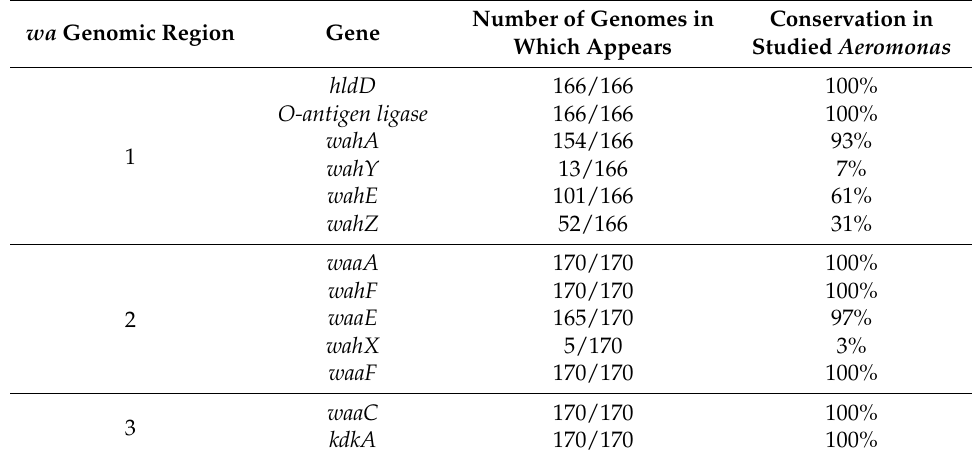
Table 1. Common genes of the wa Regions 1, 2, and 3, and their conservation in the analysed genomes. wa Genomic Region Gene